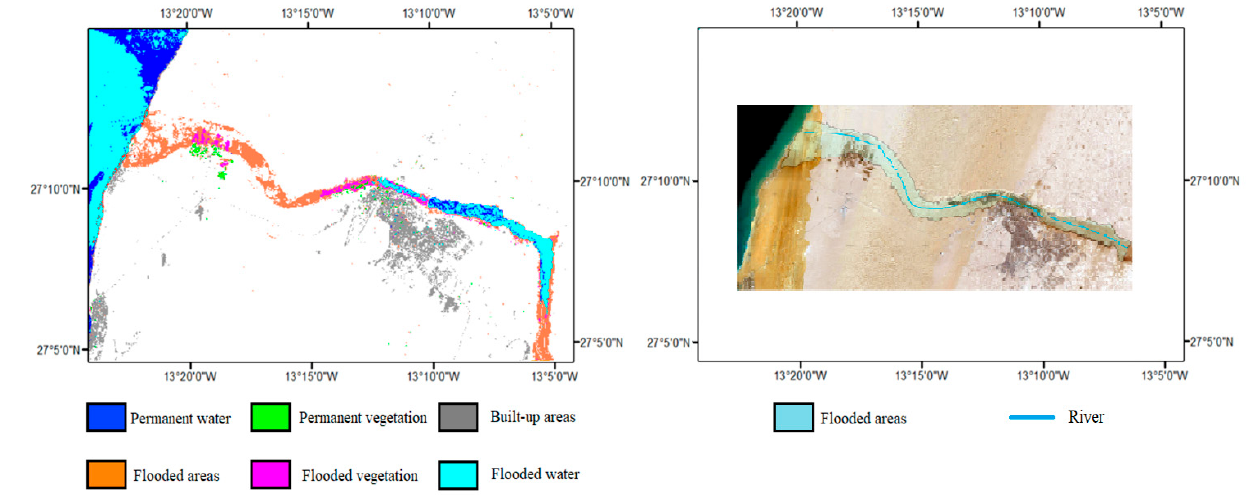
Figure 18. Comparison of remotely sensed and hydraulic-based simulation of the flash flood maps.